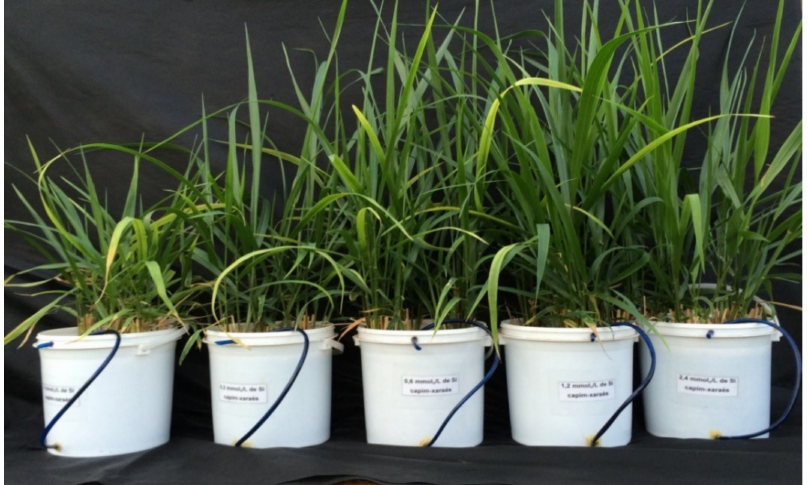
Figure 1. Xara é s palisadegrass cultivated under Al toxicity (1 mM) in ground quartz substrate and nutrients solution containing Si concentrations (0, 0.3, 0.6, 1.2, and 2.4